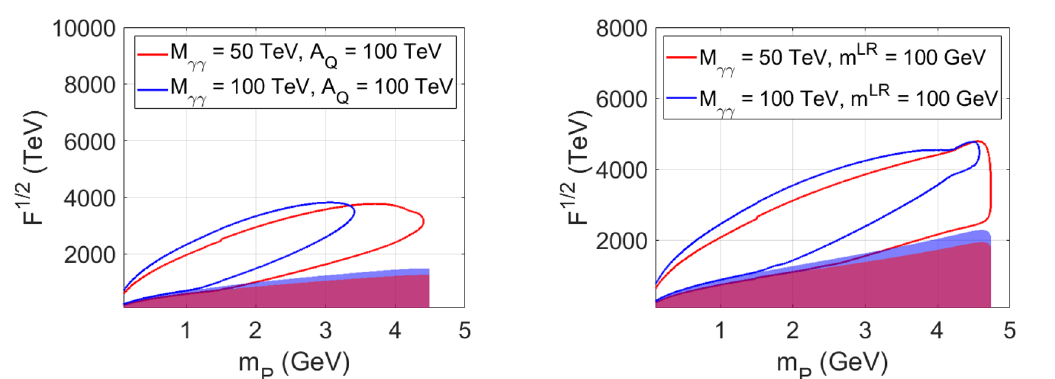
Figure 24 . Sensitivity region of FASER-II to models with sgoldstino flavor-conserving (left panel) and flavor-violating (right panel) couplings to quarks. Pseudoscalar sgoldstinos are produced in decays of beauty mesons and decay into a pair of photons. M 3 = 3 TeV. Shaded areas correspond to restrictions from table